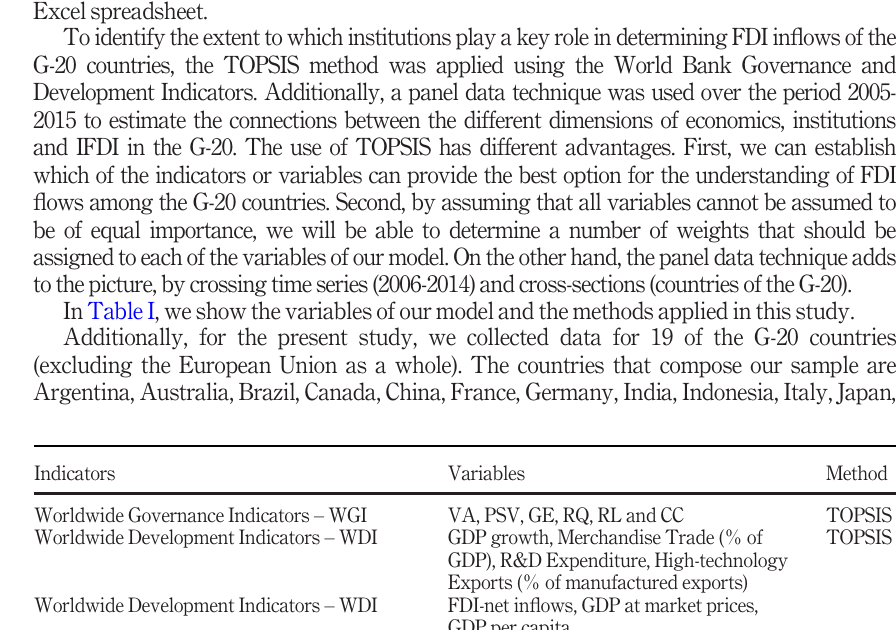
Table I. Indicators, variables and